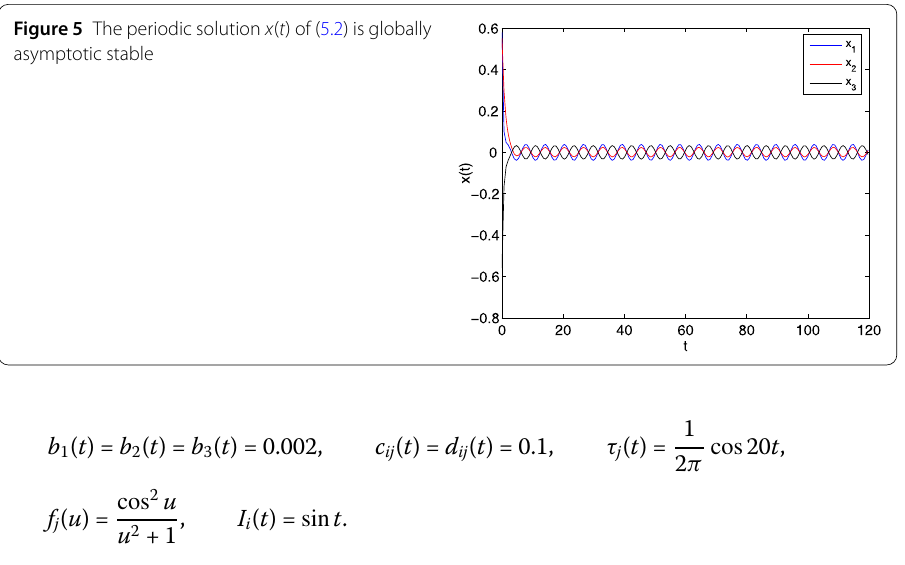
Figure 5 The periodic solution x ( t ) of (5.2) is globally asymptotic